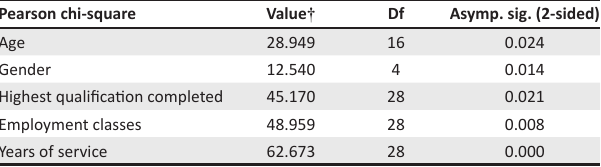
TABLE 4: Pearson correlations in terms of demographical variables. Pearson